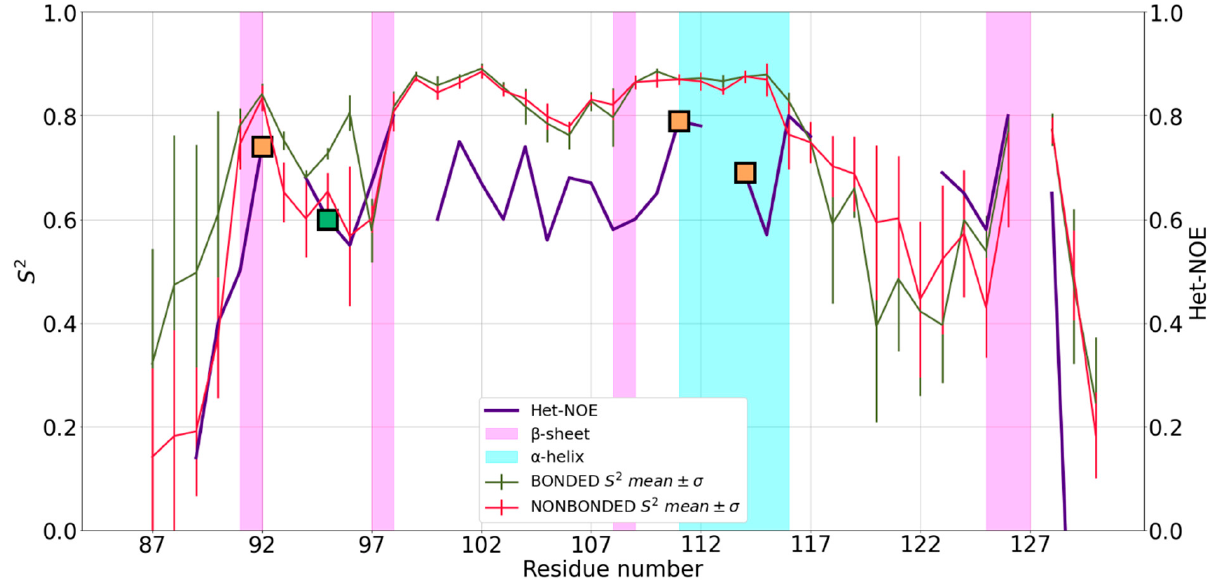
Figure 3. Mean S 2 of 5JPX and standard deviation (SD) for bonded (red) and non-bonded (green) simulations superimposed to Het-NOE data (purple). Values on y-axis were truncated at 0 because S 2 has no negative values. Orange squares represent the position in the sequence of zinc(II)-binding Cys residues, whereas the green squares represent zinc(II)-binding His residues.